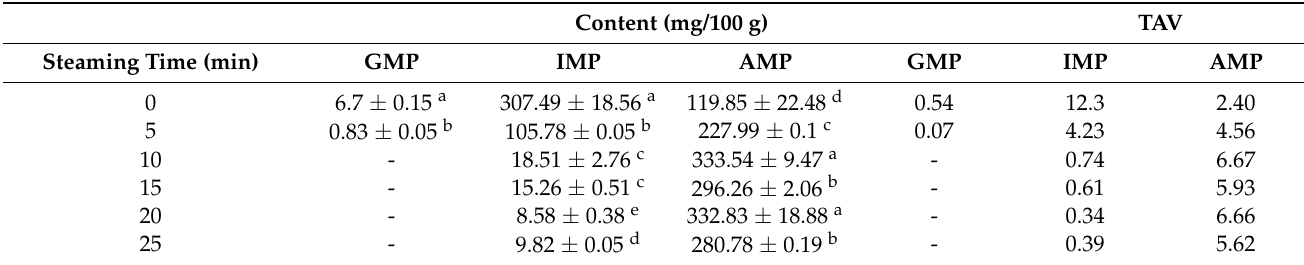
Table 4. The contents and TAVs of flavor nucleotides on a dry basis of swimming crab during steaming (mg/100 g).